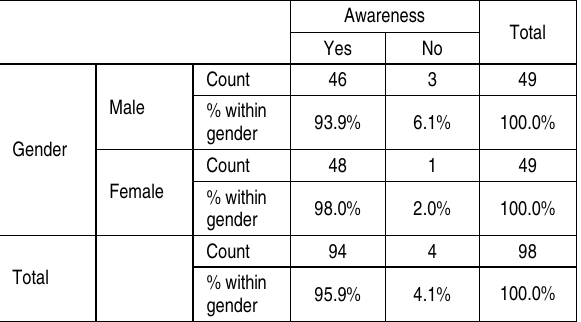
Table 2. Gender and awareness of green products